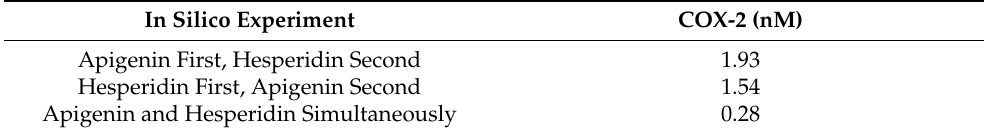
Figure 3. Individual ( A , B ) and combination effect ( C ) of apigenin and hesperidin on COX-2 produc- tion in chondrocytes over simulations periods of 2 days. Apigenin at 30 mg dose ( A ), hesperidin at 1000 mg dose, ( B ) and their combination at 1030 mg dose ( C ) reduced the levels of COX-2 over a period of 2 days. COX-2 — cyclooxygenase 2. Table 1. COX-2 estimations for additive effects of apigenin and